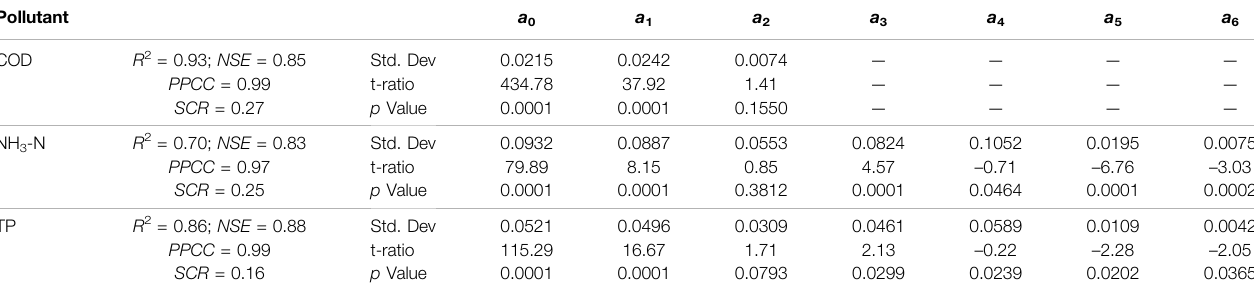
TABLE3| Regressionmodelanalysesofchemicaloxygendemand(COD),ammonianitrogen(NH 3 -N),andtotalphosphorus(TP).Std.Dev,standarddeviation; NSE ,Nash- Sutcliffe ef fi ciency value; PPCC , probability plot correlation coef fi cient; SCR , serial correlation of residuals. Pollutant